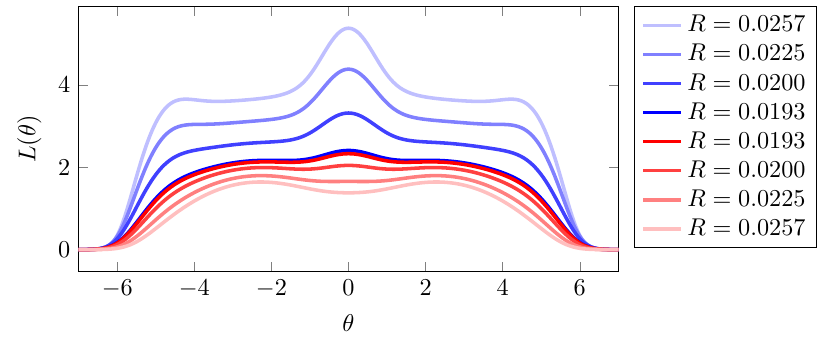
Figure 7. L ( θ ) for both the primary (red) and secondary (blue) branch solutions as R approaches the critical value R . For each color (blue or red), the color gradient indicates the decrease of R ∗ towards R , where the two branches merge. Here θ ∗